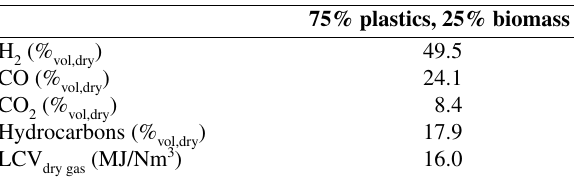
Table 1. Basic composition of the feedstocks as used in the model. 4